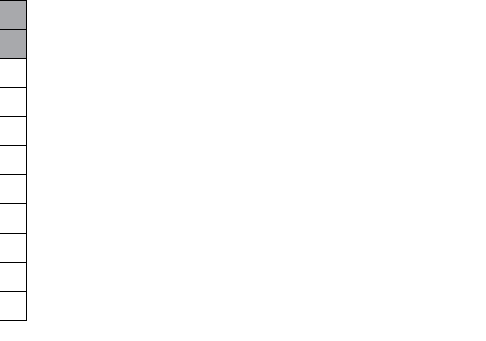
Table 2. The effect of interferences on the determination of MNs (n =